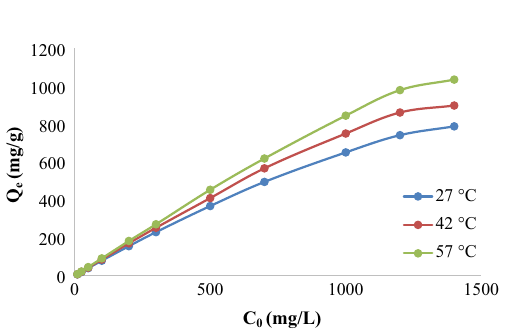
Figure 6. Effect of dose on adsorption performance of Ox-FVESP for KMnO 4.